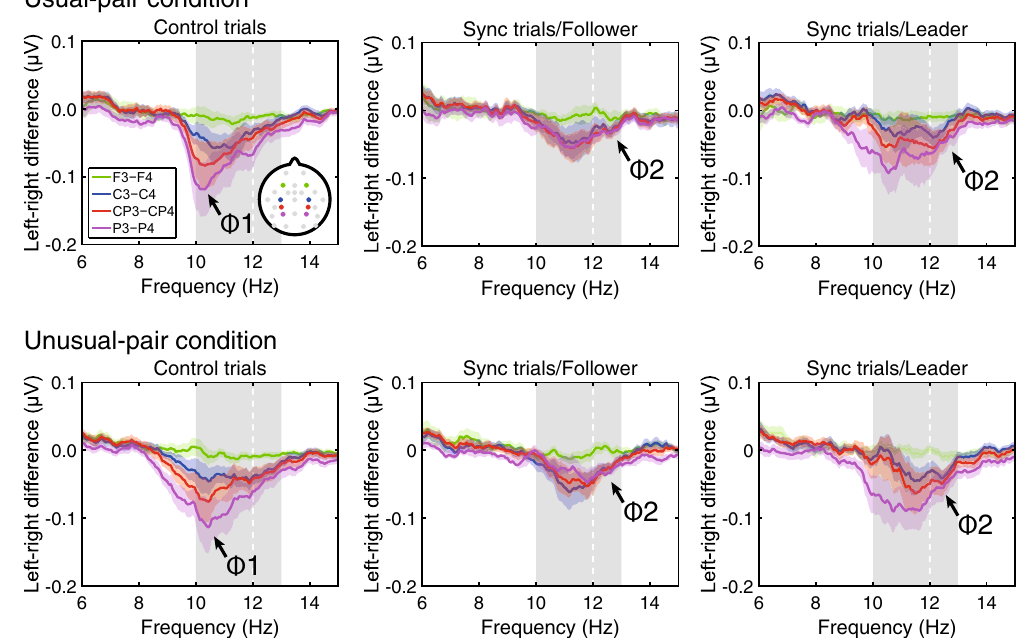
Figure 2. Results of the frequency analysis for the phi complex. The difference in amplitudes for each frequency between the left hemisphere and the right hemisphere was calculated as described in a previous study 20 . The grand means of all 16 participants are plotted in the figure as solid lines. Standard errors are overlapped with the line plots as shaded areas. Grey shaded areas represent scored areas for the phi